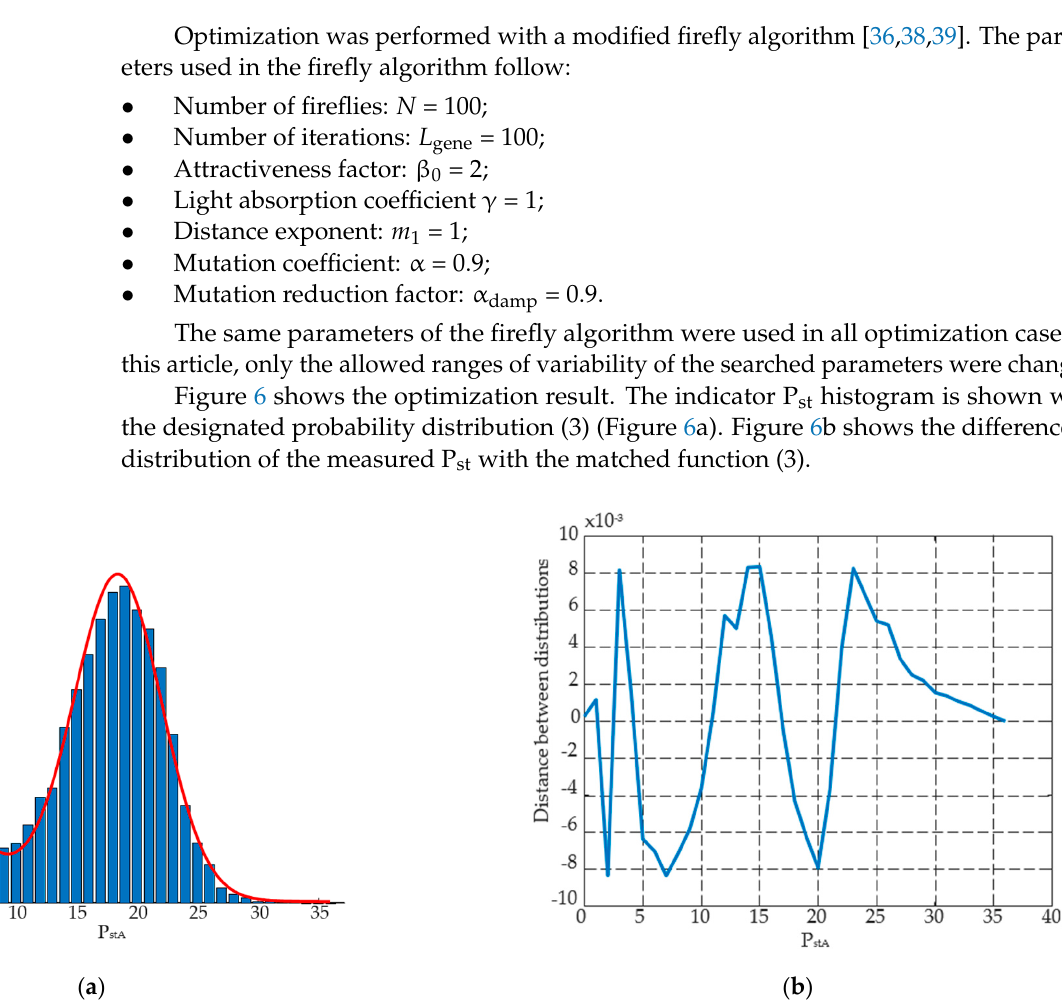
Figure 5. Example of the Kolmogorov–Smirnov test.